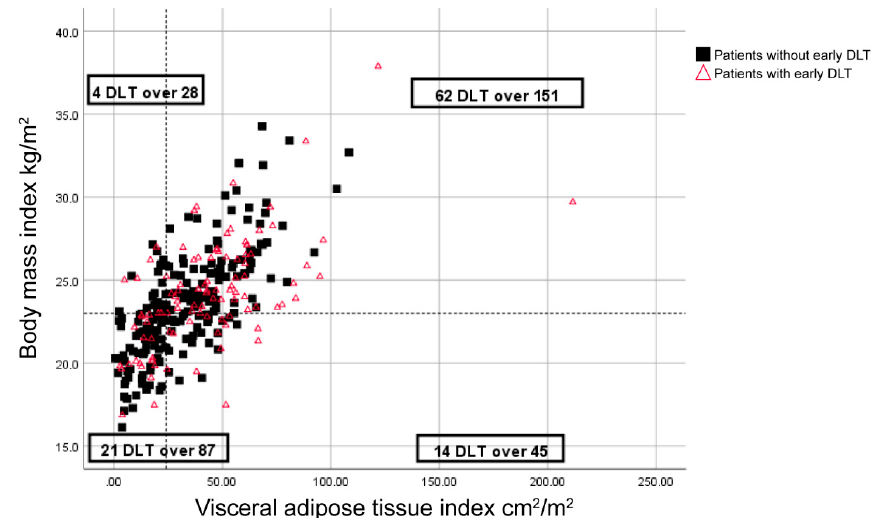
Figure 1. Distribution of body mass index (BMI), visceral adipose tissue index (VATI), and early dose-limiting toxicity (DLT) for sunitinib-treated patients. Symbols represent individual patients. The vertical dashed-line indicates the cut-off point for low VATI (<24 cm 2 /m 2 ), and the horizontal dashed line indicates a BMI of 23 kg/m 2 .